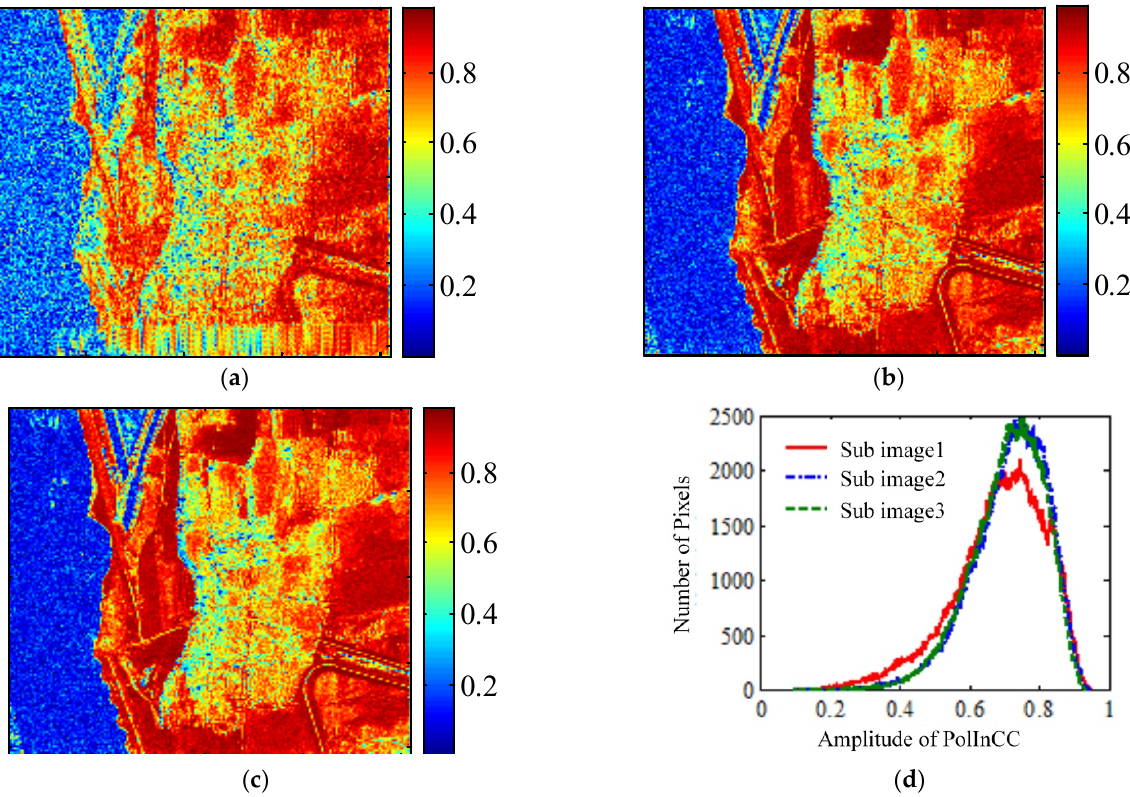
Figure 7. Amplitudes of PolInCCs for different sub-views of the HV channel. ( a ) amplitude of PolInCCs for sub-view 1, ( b ) amplitude of PolInCCs for sub-view 2, ( c ) amplitude of PolInCCs for sub-view 3, and ( d ) statistical curve of PolInCCs’ amplitudes in different sub-images. To examine the relationship between the forest and the scattering phase, the interfero- metric phase images of different sub-views of HV channel images were obtained from